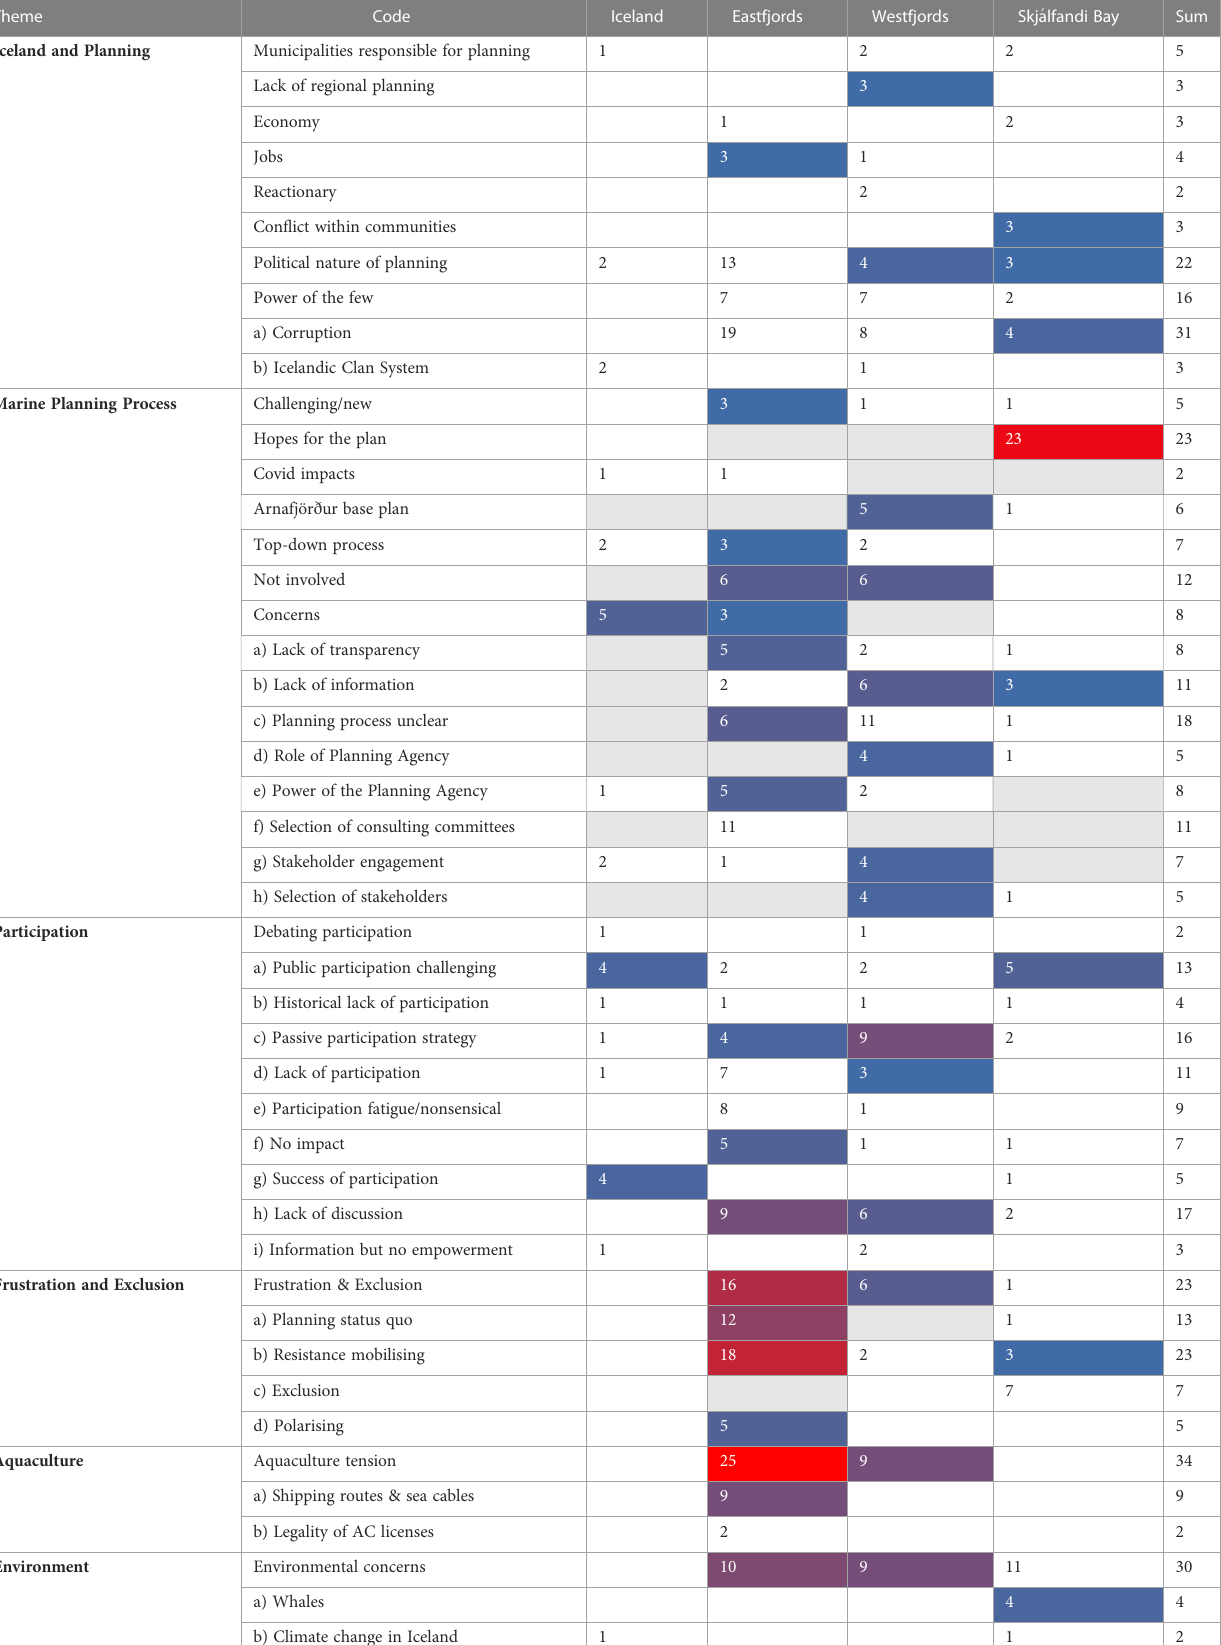
TABLE 1 Code and Theme Matrix broken down in document groups.